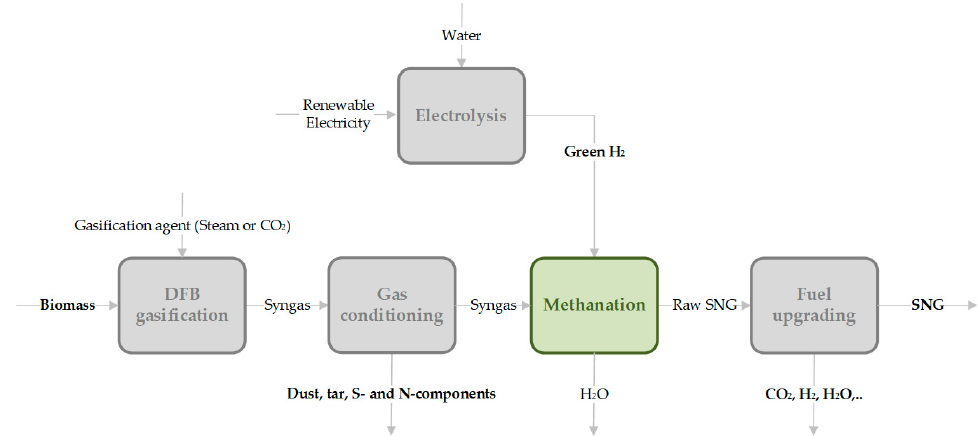
Figure 2. General process route of thermochemical conversion of solid biomass (carbon source) via catalytic methanation to a synthetic fuel (e.g., SNG).